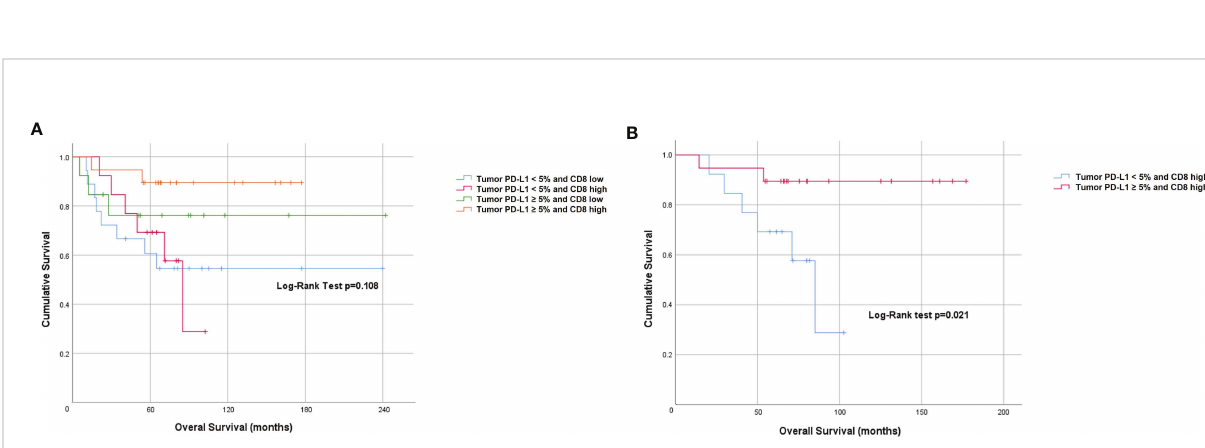
FIGURE 4 Prognostic value of combined tumor PD-L1 positivity score and CD8 expression. Kaplan-Meier plots indicating (A) Overall survival strati fi ed by PD-L1 and CD8 high and low level and (B) Overall survival of patients strati fi ed by high CD8 and PD-L1 (<5% and ≥